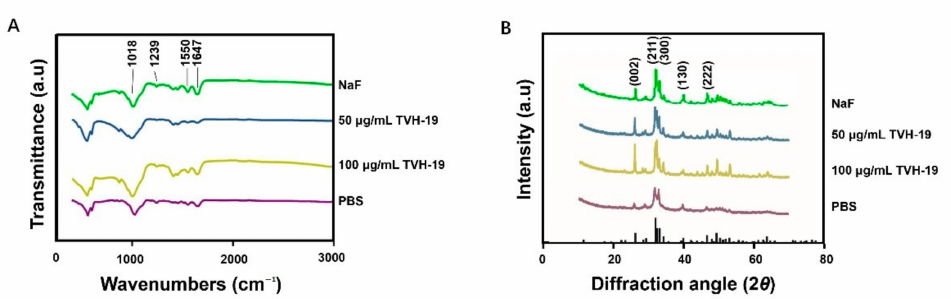
Figure 5. ( A ) ATR–FTIR spectra of dentin slices surface. ( B ) XRD spectra of dentin slices surface. The PDF card JCPDS 09-0432 showed the standard diffraction peak pattern of